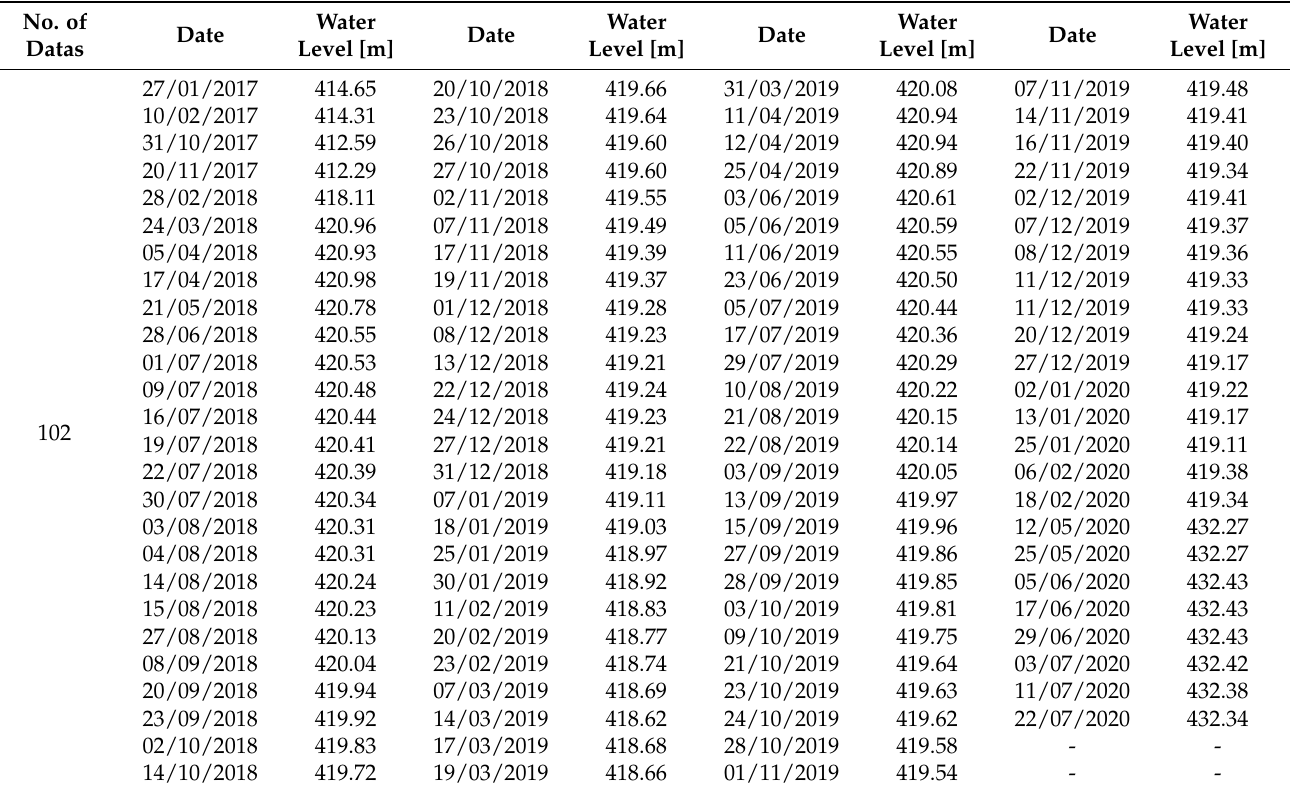
Table 5. Observed water levels used to assess the